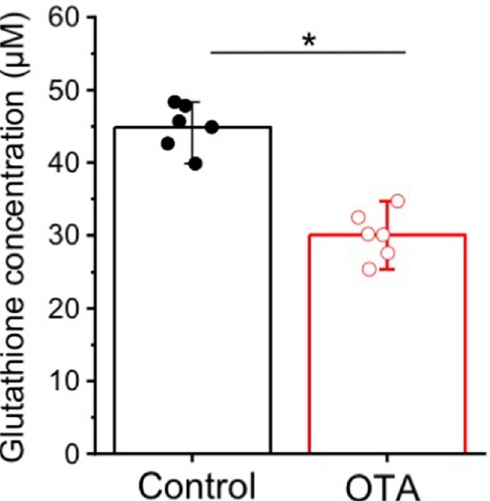
Figure 6. Glutathione levels in extracts of zebrafish embryos (72 hpf) exposed to OTA (1 µM for 24 h) as compared to Control embryos. Glutathione (GSH) levels were analysed by using GSH assay kit from Sigma- Aldrich. Significant reduction of GSH (* P < 0.001; n = 6) in OTA-treated embryo is clearly